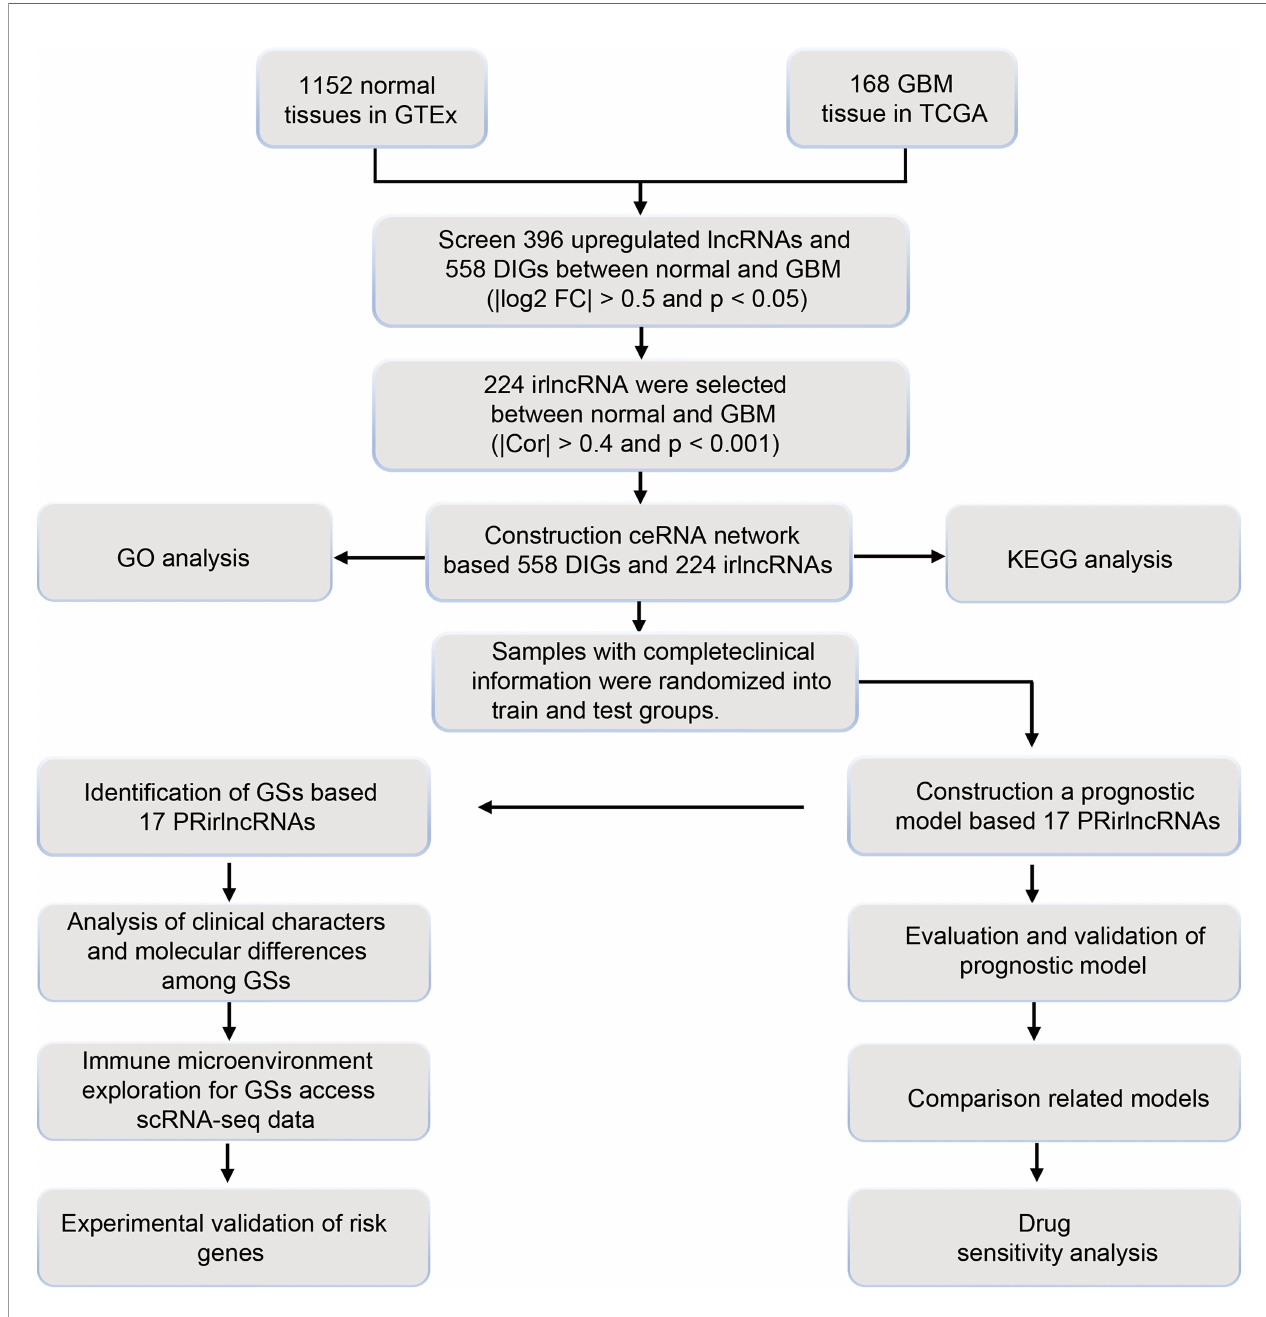
FIGURE 1 | Flow chart of study